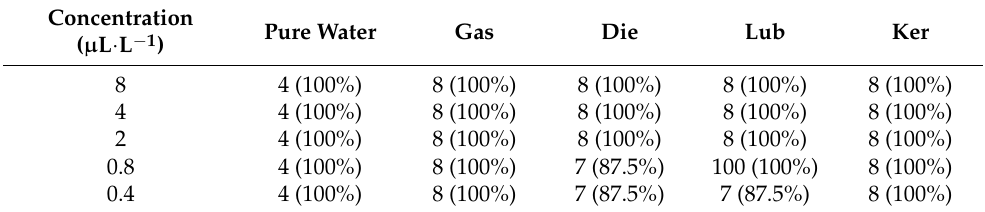
Figure 5. Graphic representation of the linear discriminant analysis (LDA) (D 36X980 ) F 1 and F 2 values of all the samples. Table 5. LDA data corresponding to the total and percentage of successful pure water and PDP-added sample